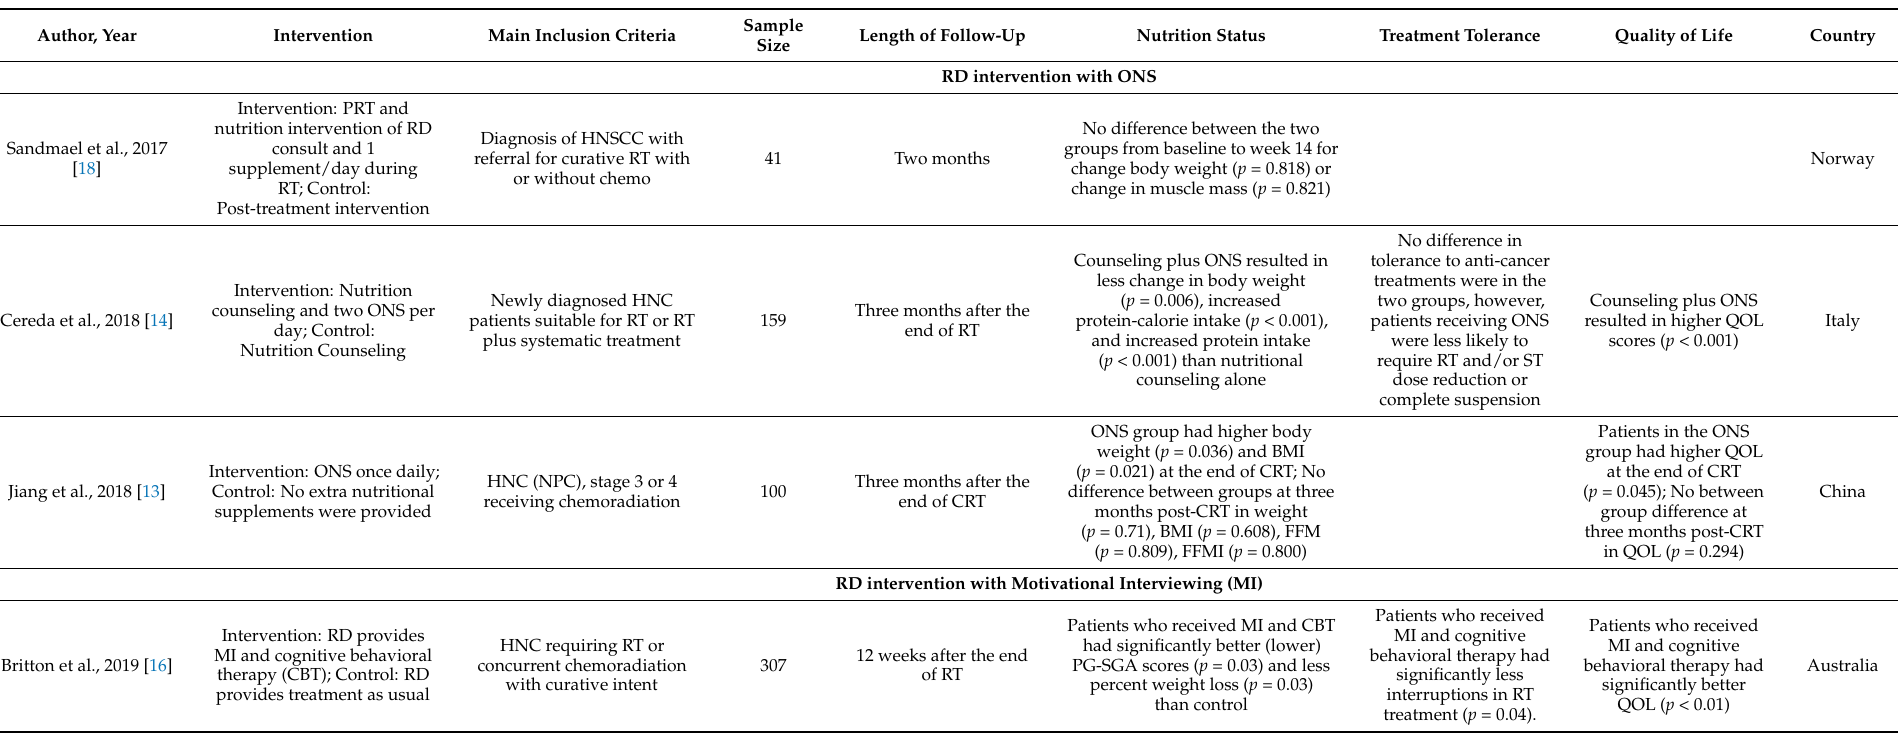
Table 2. Characteristics of studies reporting nutrition interventions in patients with head and neck